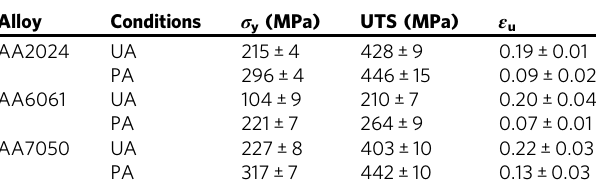
Table 1 The yield strength ( σ y ), ultimate tensile strength (UTS), and uniform tensile elongation ( ε u ) of the under aged (UA) and peak aged (PA) AA2024, AA6061, and AA7050